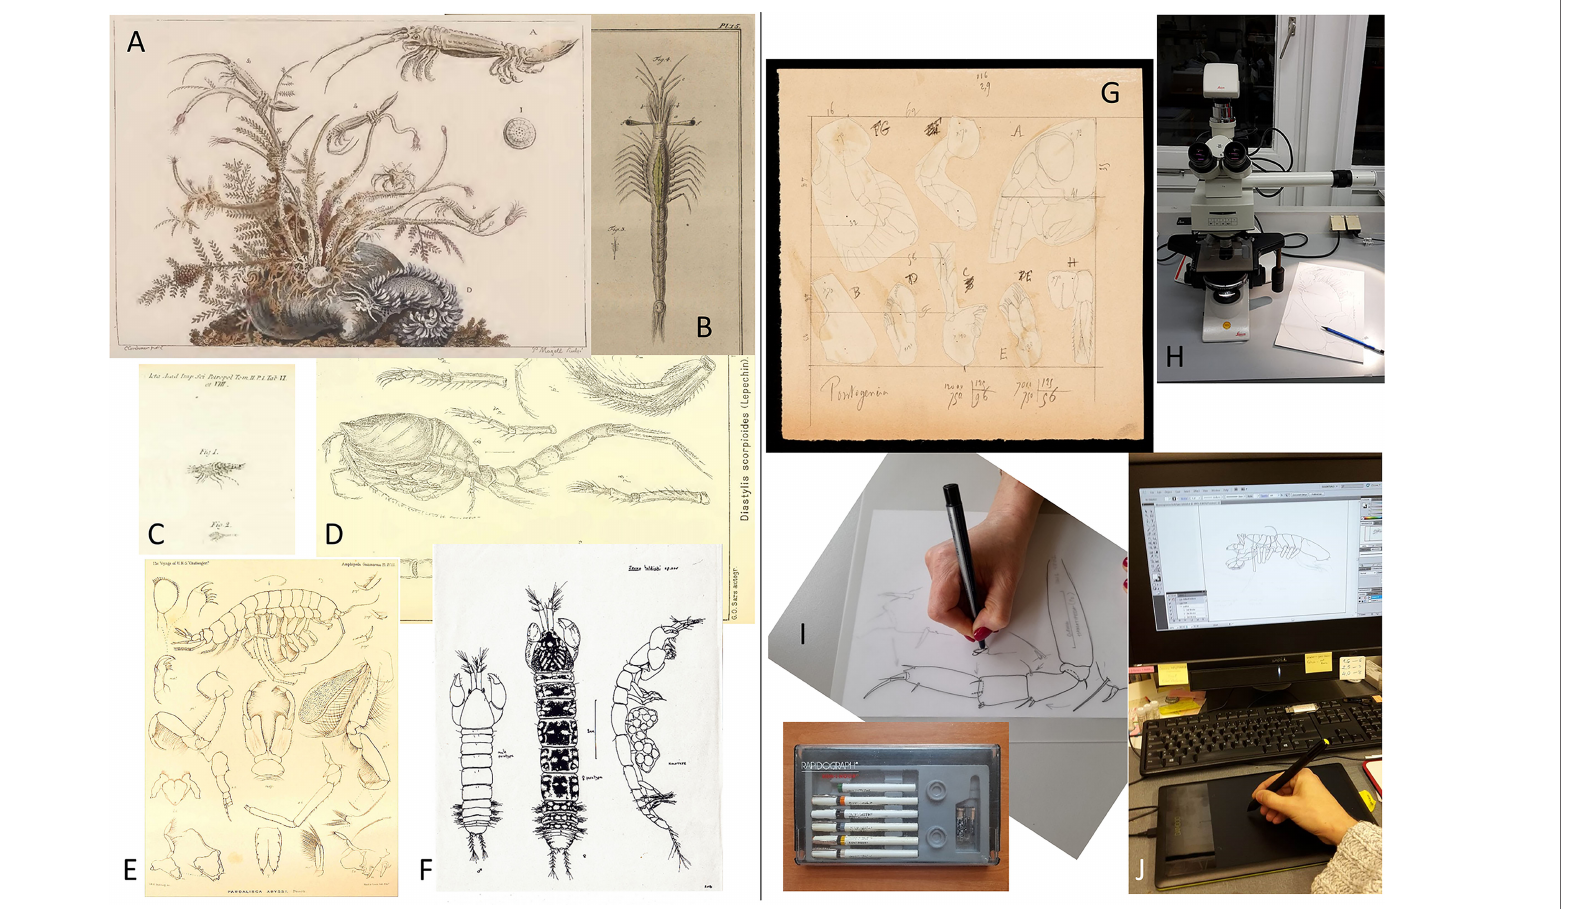
FIGURE 1 | Scienti fi c illustrations of peracarids as complement of taxa description from past to present. (A) Isopod genus Astacilla Cordiner, 1793 illustrated by Cordiner (1793). (B) Mesopodopsis slabberi (van Beneden, 1861), the earliest illustrated mysid by Slabber (1778). (C) Diastylis scorpioides (Lepechin, 1780), the earliest published illustration of a cumacean as Oniscus scorpioides Lepechin, 1780 (see Holthuis, 1964). (D) Diastylis scorpioides (Lepechin, 1780), illustrated by G.O. Sars more than one century later (G.O. Sars, 1900). (E) The amphipod Pardalisca abyssi Boeck, 1871 illustrated after the voyage of H.M.S. Challenger during the years 1873 – 76 (Stebbing, 1888). (F) Original hand inked drawing made by Roger Bamber for the description of the tanaid Zeuxo holdichi Bamber, 1990. (G) Original plate outline with the drawings made by E ́ douard Chevreux for the amphipod description Pontogeneia minuta Chevreux, 1908 (Crustacean collection MNHN). (H) Compound microscope equipped with camera lucida to draw specimens for taxonomical purposes (photo I Frutos). (I) Preparing a plate by hand inking from previously made pencil drawings (photo I Frutos). (J) Electronical inking of drawings using a drawing tablet and computer (photo I